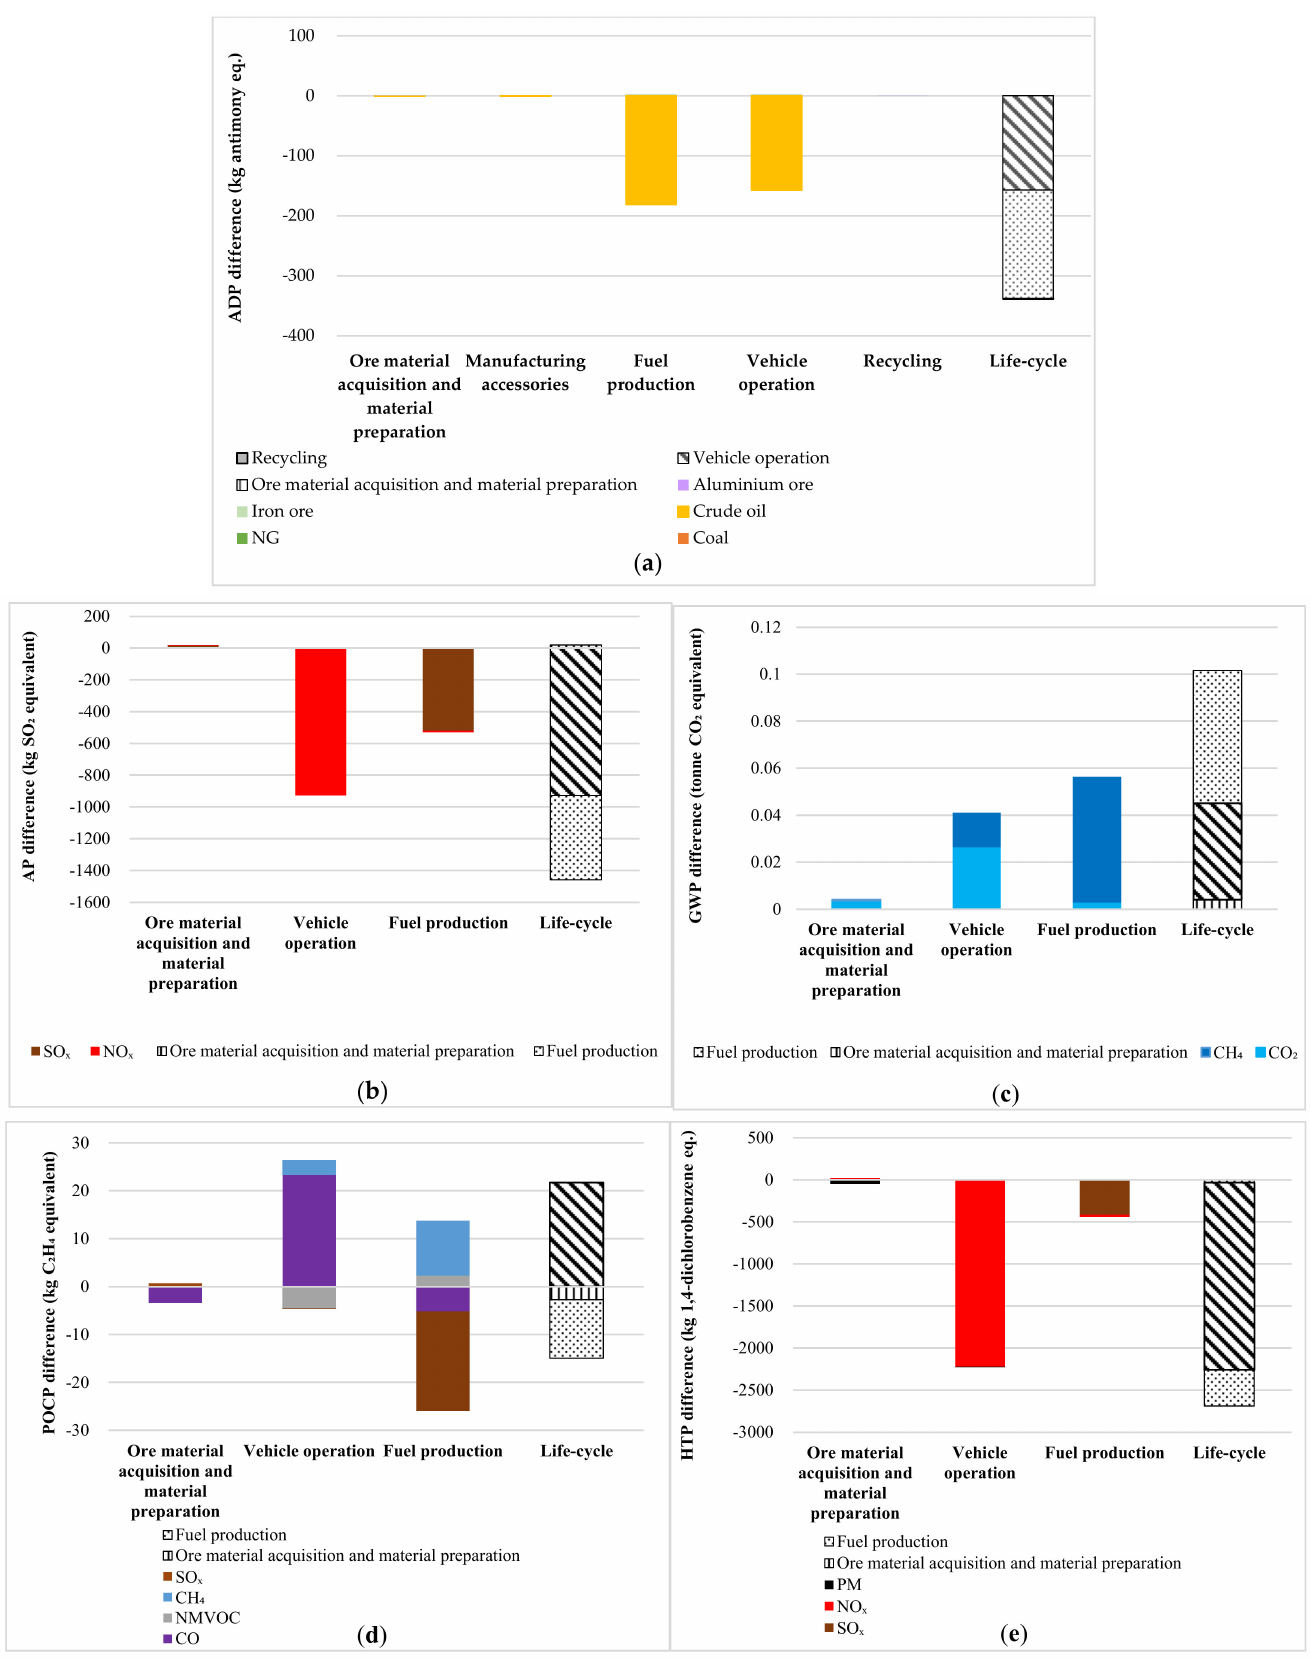
Figure 5. Environmental impacts of LNG tractor-trailer compared to diesel tractor-trailer: ( a ) abiotic depletion potential (ADP); ( b ) acidification potential (AP); ( c ) global warming potential (GWP); ( d ) photooxidant creation potential (POCP); ( e ) human toxicity potential